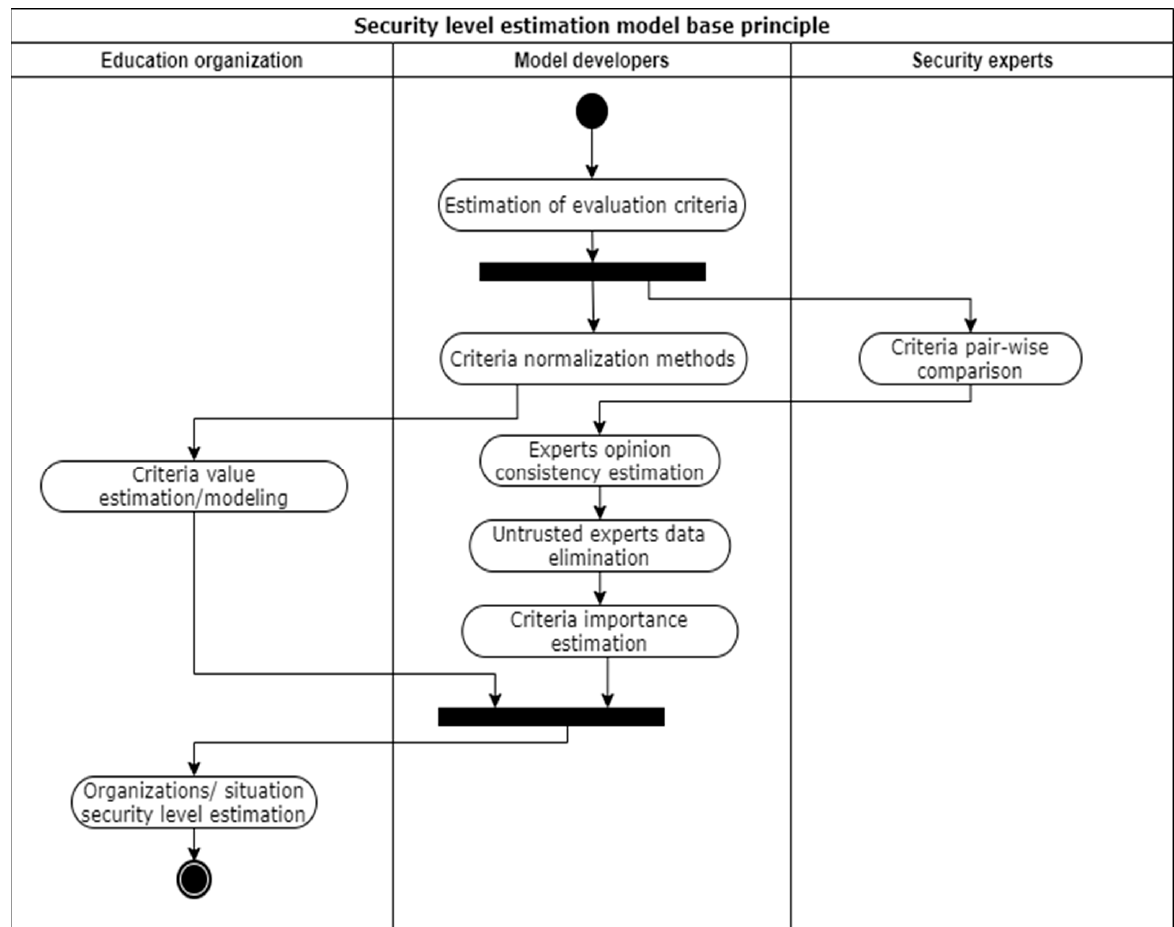
Figure 2. Principle schema of education organization security level estimation model.